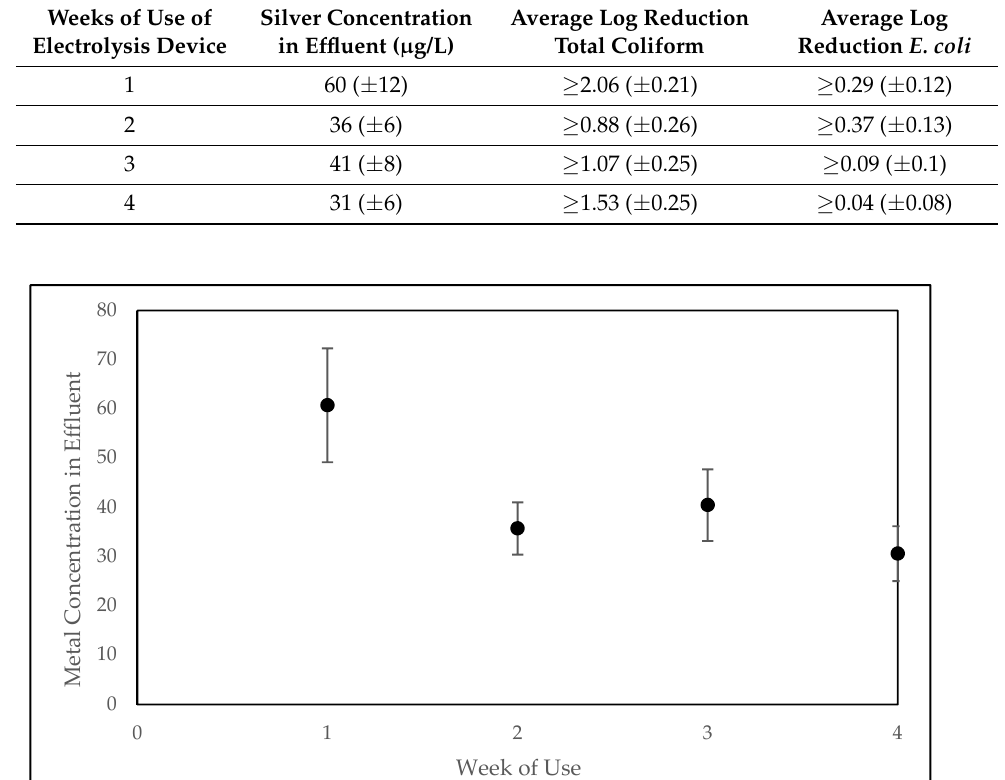
Figure 12. Mean values for silver concentration in effluent water from the intervention. Error bars indicate the standard error above and below the mean.